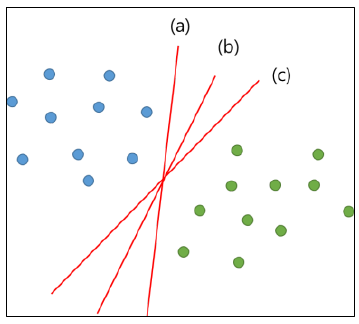
Figure 4. Examples of possible decision boundaries